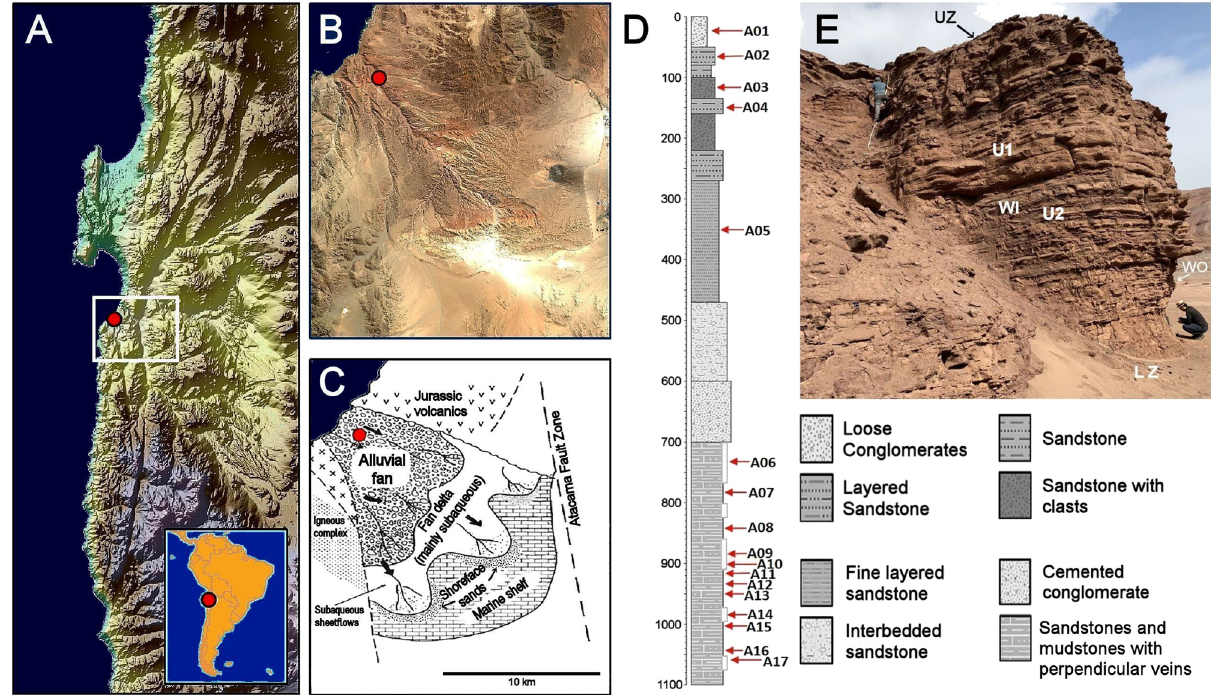
Fig. 1 | Red Stone location and geological characteristics. A Red Stone Location in the Atacama Desert (digital terrain model 86 ). B Satellite image zooming in the surrounding region (Sentinel 2020 satellite data). C Paleogeographic reconstruc- tionofthealluvial/deltasystemshownin B ,accordingtothereportedsedimentary recordof the Caleta Coloso-El Wayformation(modi fi ed from Flint, S.Clemmey,